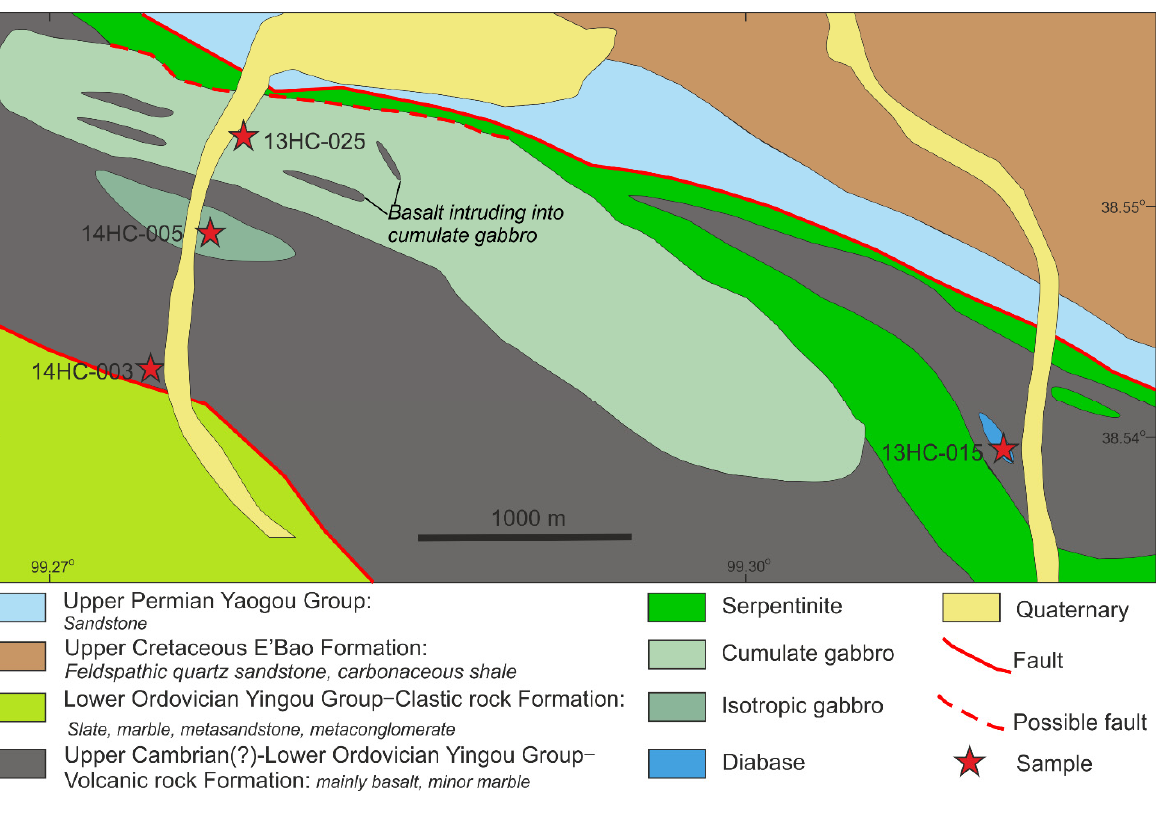
Figure 2. Geological map of Hongtugou. Modified after the map made by the No.6 Gold Geological Party of the Chinese Armed Police Force.